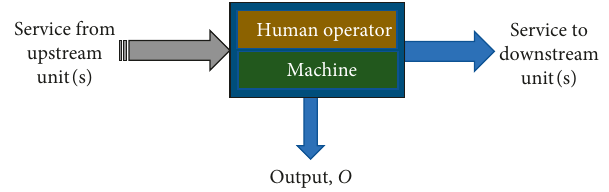
Figure 1: Node is modeled as operational unit which represents human or organization controlling automated machine. The op- eration of unit may depend on the service of other upstream units. Each unit serves a certain amount of demand in their service area, producing output O for the